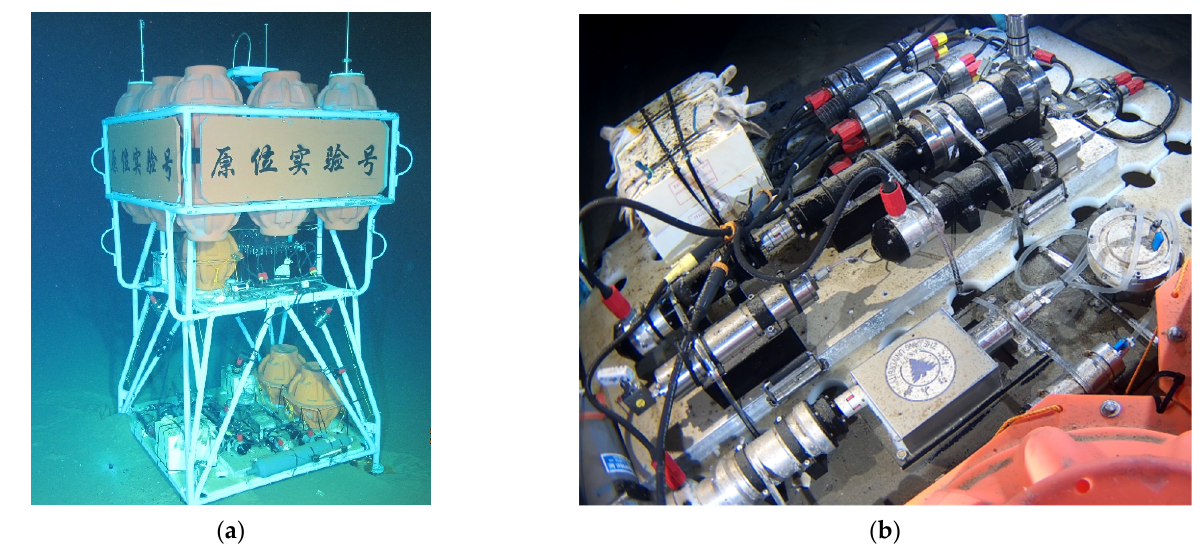
Figure 14. Field equipment diagram of sea trial. ( a ) Sea trial overall equipment diagram ( b ) The in situ multi-stage filtering and preserving device scene diagram. Table 4. Sea trial results.